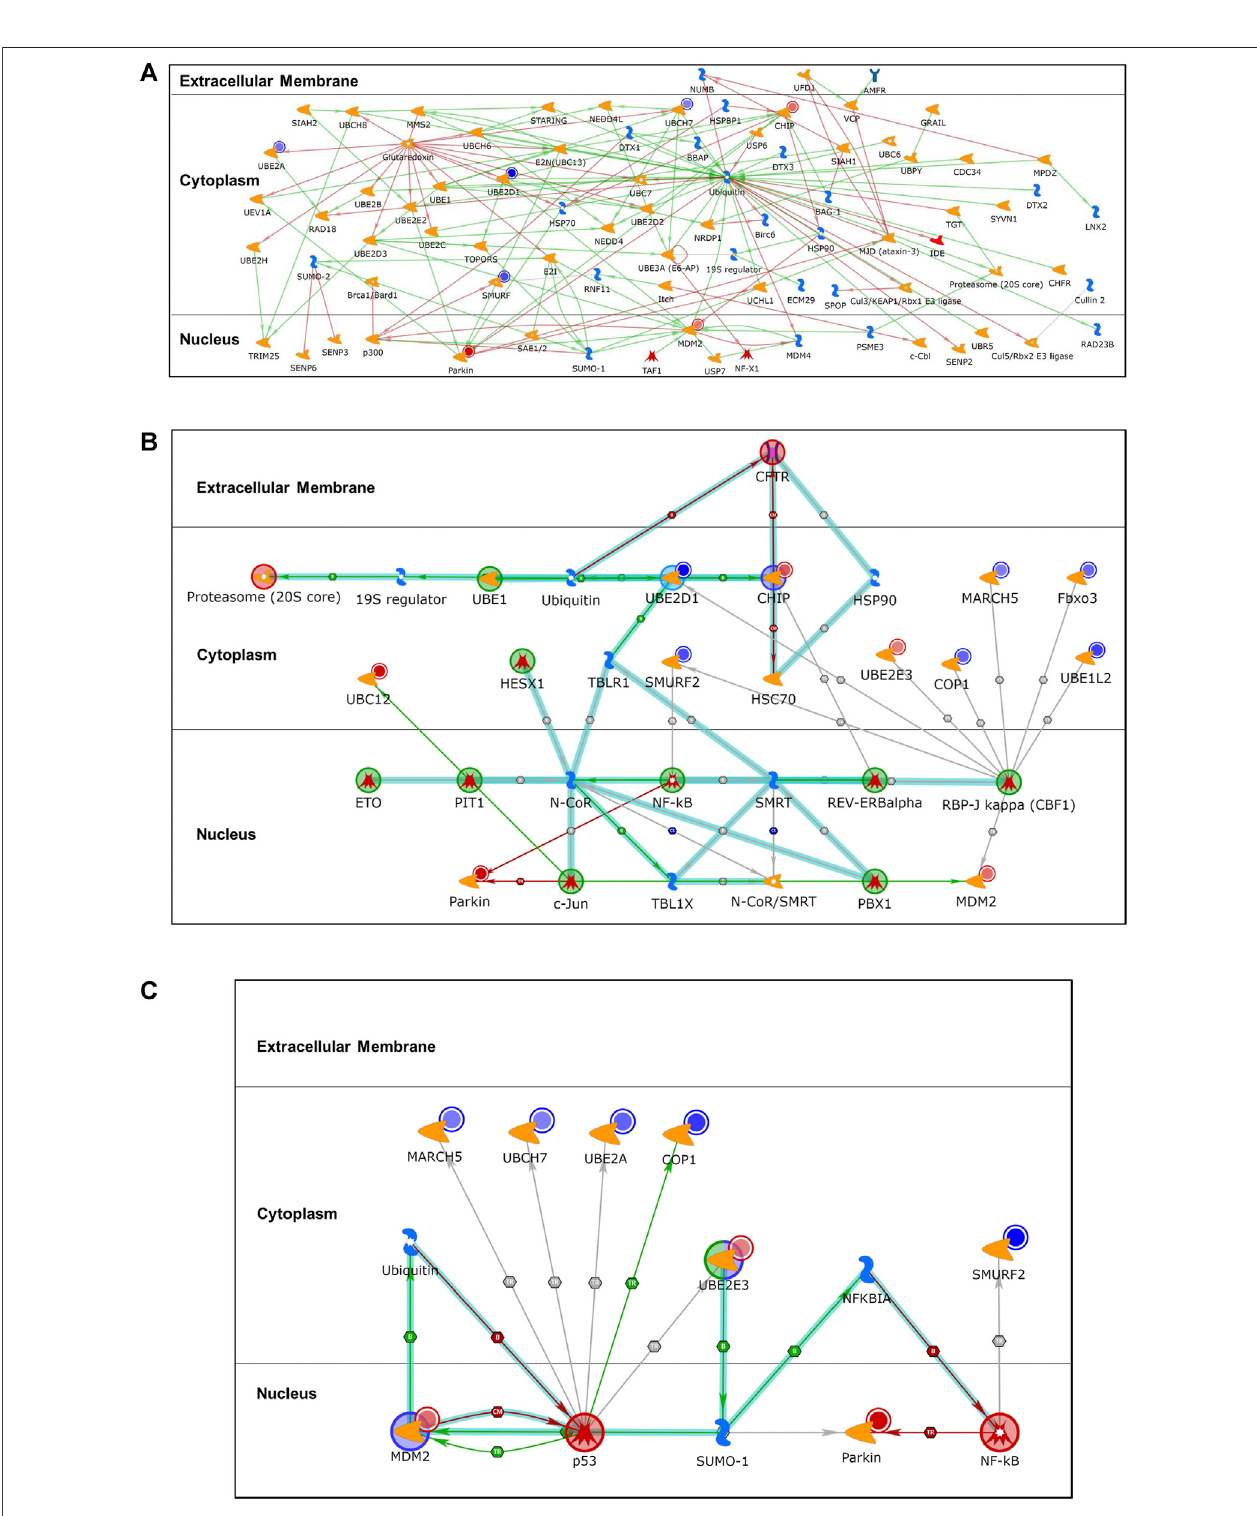
FIGURE 2 | Differentially expressed gene enrichment analysis of the top scored process networks. Relationship between differentially expressed ubiquitination genes ( p ≤ 0.050) in the case (SMA; n (cid:1) 21) and control (M l MA; n (cid:1) 23) groups was determined using enrichment analysis to identify process networks on MetaCore ™ . Additional enrichment analysis for same differentially expressed genes ( p ≤ 0.050) was done using canonical pathway modeling to map out associated subnetwork